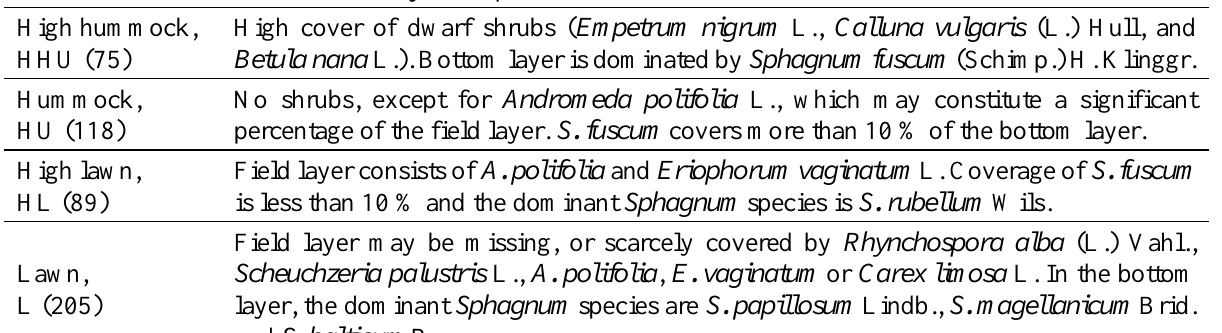
Table 1. Mire surface types at Siikaneva II. The Cottongrass tussock (CG) class is not an original microform; it was added during the field campaign because it was clearly visible in the aerial images (cf. Kalacska et al . 2013). Surface class (N) Plant community description High hummock, High cover of dwarf shrubs ( Empetrum nigrum L., Calluna vulgaris (L.) Hull, and HHU (75) Betula nana L.). Bottom layer is dominated by Sphagnum fuscum (Schimp.) H. Klinggr.